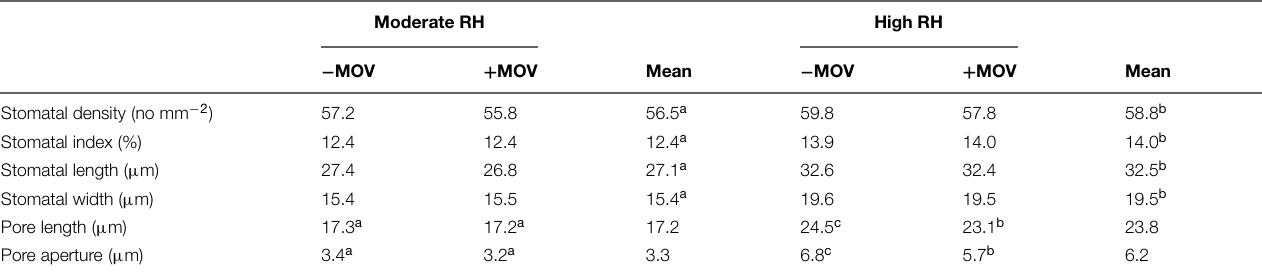
FIGURE 1 | Transpiration rate in intact plants during light (A) and dark (B) grown plants, starting when the flower bud had cylindrical shape and pointed period in pot rose cv. ‘Toril’ grown at moderate (61%) or high (92%) RH, tip. Values are the mean of 14 intact plants and bars represent the SEM. without (open columns) and with (solid columns) additional MOV. Different letters indicate significant differences according to Fisher’s LSD test Measurements were conducted throughout three consecutive days in fully ( P = 0.05). TABLE 2 | Stomatal characteristics of pot rose cv. ‘Toril’ grown at moderate (61%) or high (92%) RH, without ( − MOV) or with ( + MOV) additional MOV in intact fully expanded leaves, 4 h after the beginning of the light period. Moderate RH High